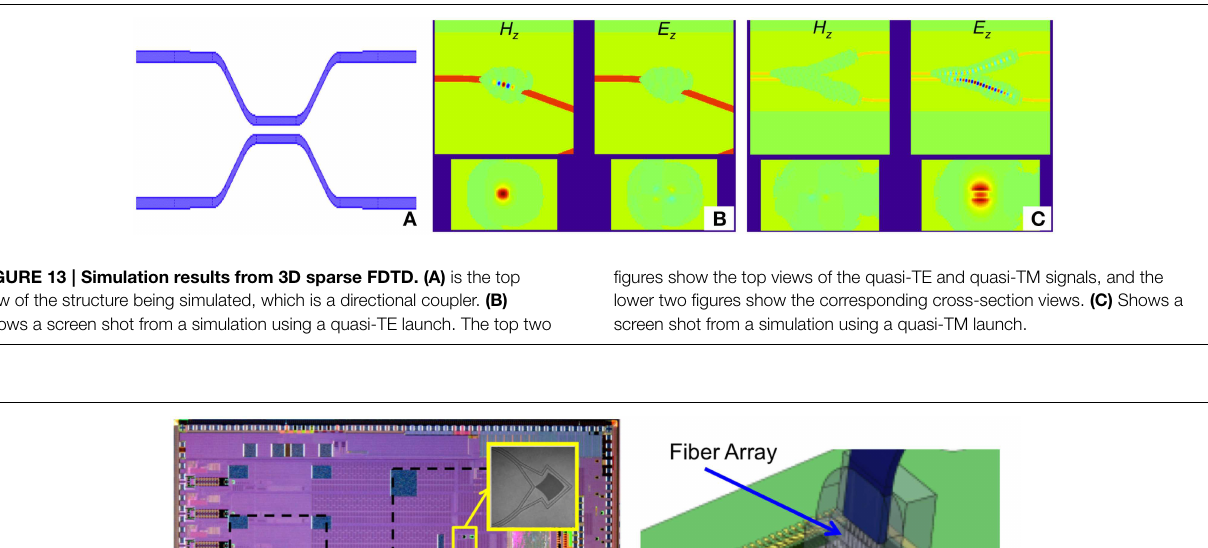
figures show the top views of the quasi-TE and quasi-TM signals, and the lower two figures show the corresponding cross-section views. (C) Shows a screen shot from a simulation using a quasi-TM launch.